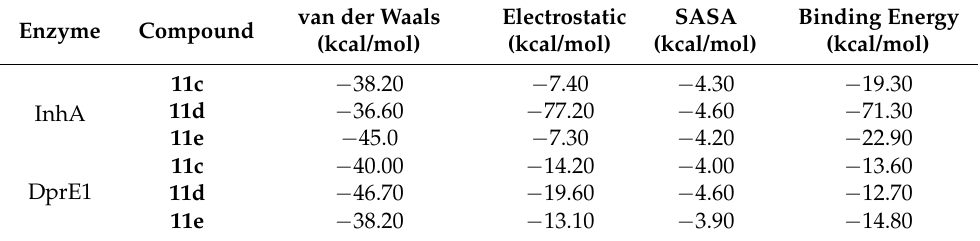
Table 6. Free binding energy of the interaction in the complex between studied ligands and